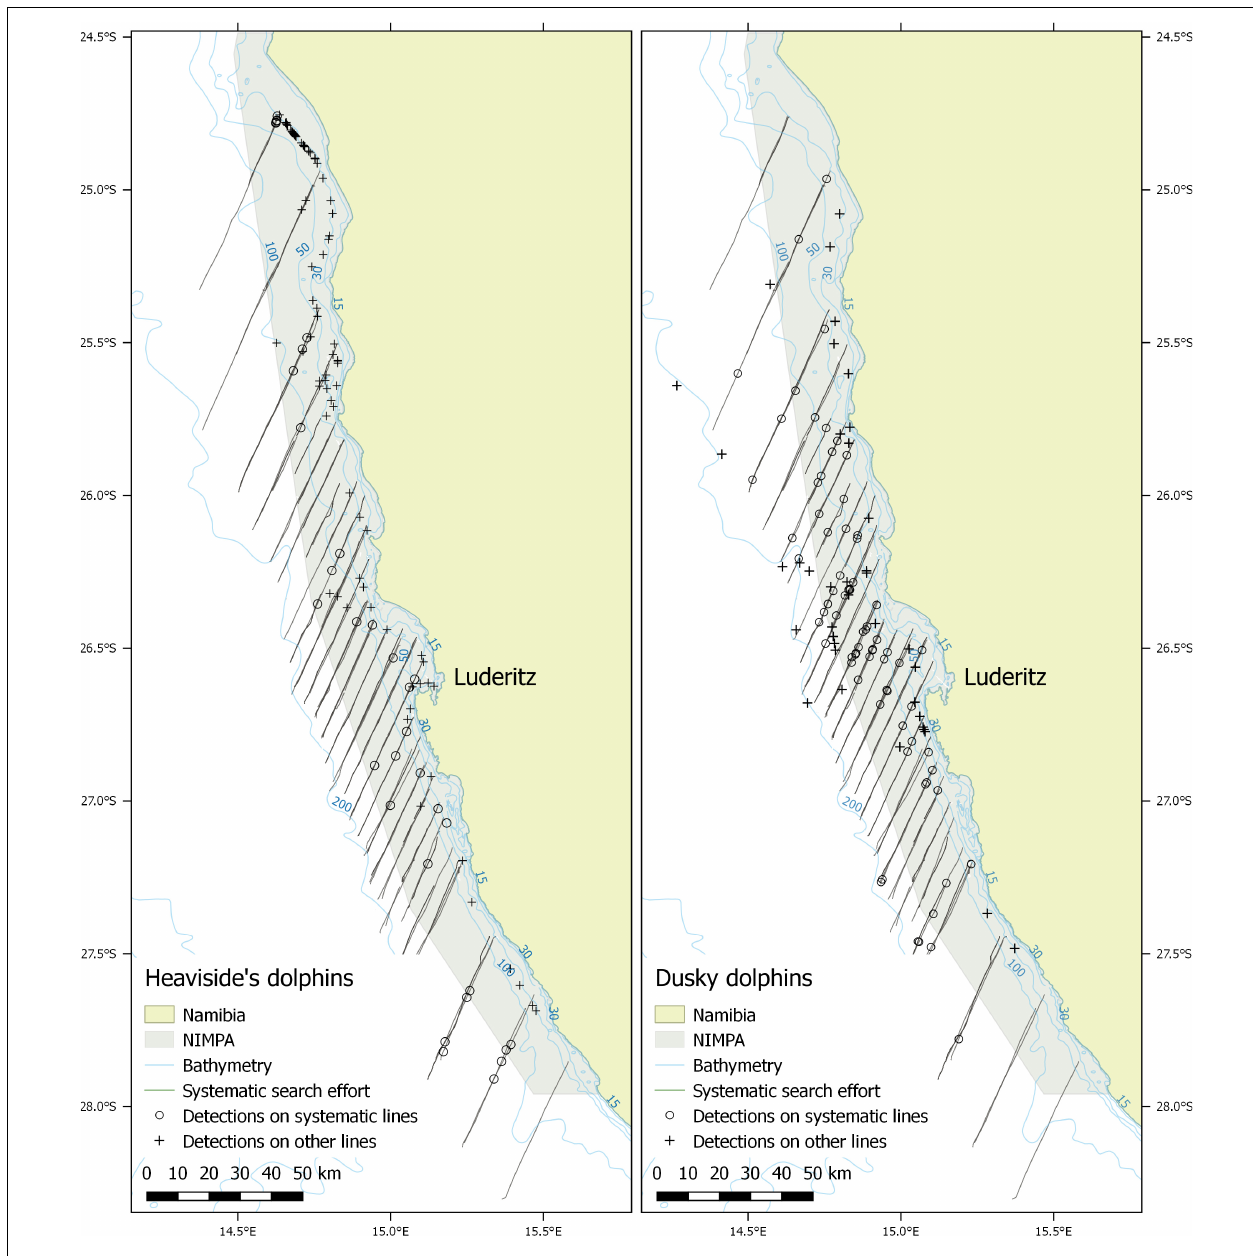
FIGURE 7 | Systematic line transect survey effort by the combined platform and acoustic single platform (dark lines) with Heaviside’s and dusky dolphin systematic detections (circles) used to estimate density and abundance during 2012-2014. Detections made on survey effort but on non-systematic lines are shown as ‘+’ symbols. There is evidence of coastal clustering of Heaviside’s dolphin detections primarily in the northern and central strata. The most northern and southern individual transect lines were not